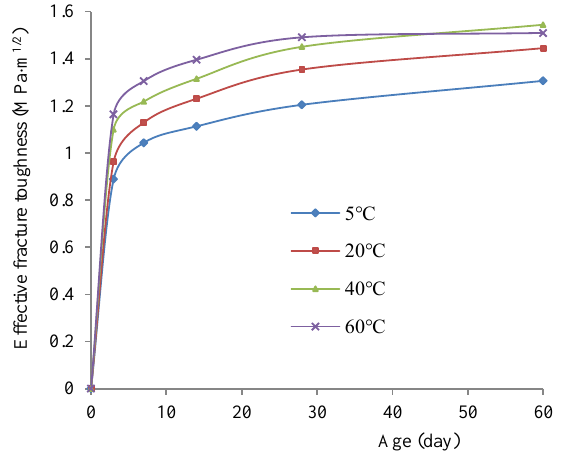
Figure 5. E ff ective fracture toughness for concrete exposed to dry environments with Figure 5. Effective fracture toughness for concrete exposed to dry environments with different di ff erent temperatures.